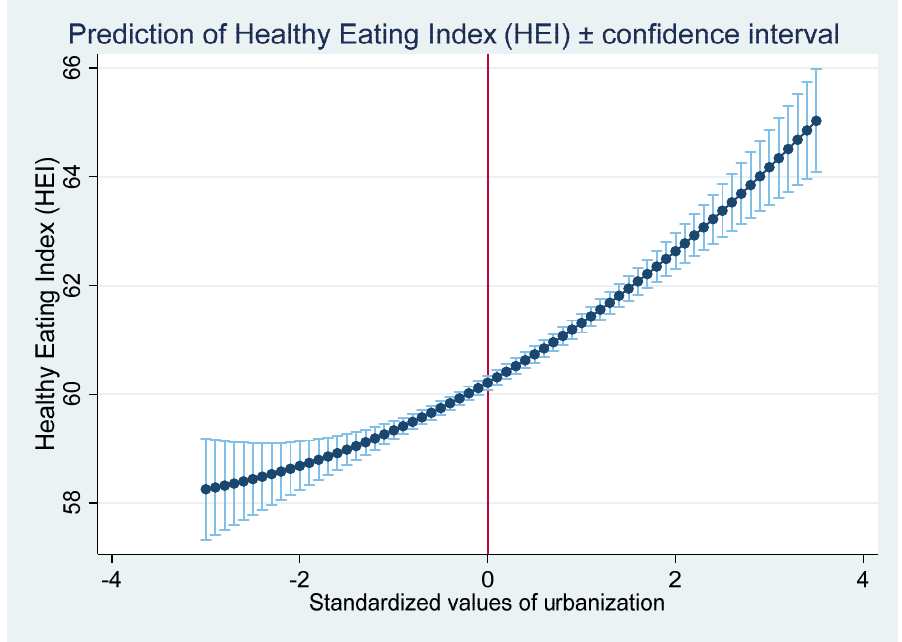
Figure 3. The relationship between urbanization and the predicted Healthy Eating Index (HEI). Table 6. The effect of urbanization on nutrition and the Healthy Eating Index (HEI) by gender. Variables